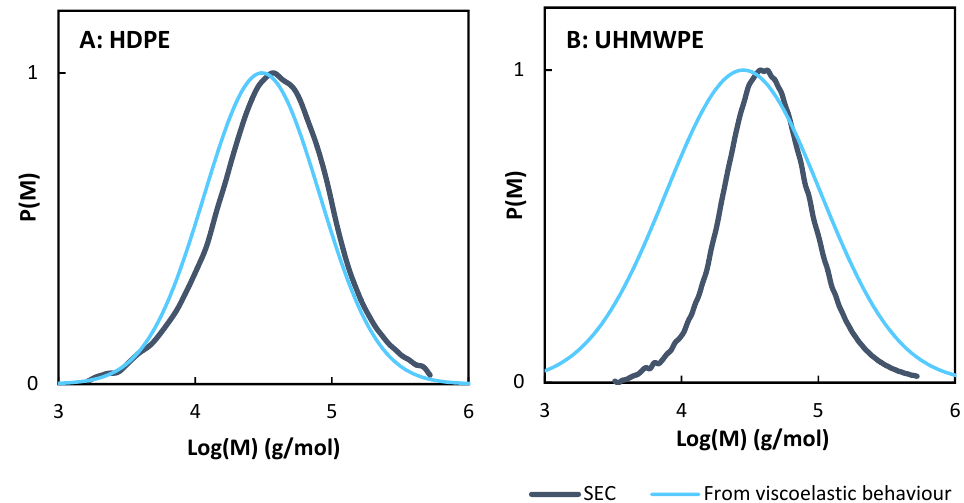
Figure 8. Molecular weight distribution obtained by SEC and viscoelastic measurements for ( A ) HDPE extruded at 390 °C, 3 kg/h and 1000 rpm and ( B ) UHMWPE extruded at 390 °C, 1 kg/h and 1000 rpm.